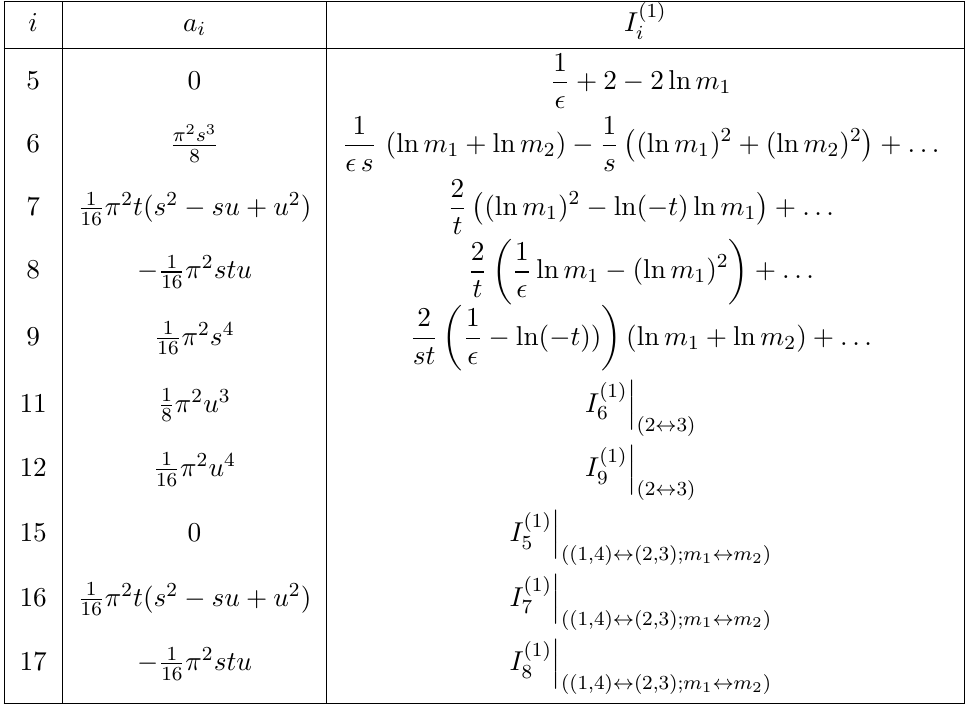
Table 4 . Master integrals in the physical region and their coe(cid:14)cients in the small-mass limit. Integrals not included explicitly do not have any ln m i singularities. Ellipsis contain terms which are regular in the small-mass limit but may contain divergence in the dimensional regulator (cid:15)